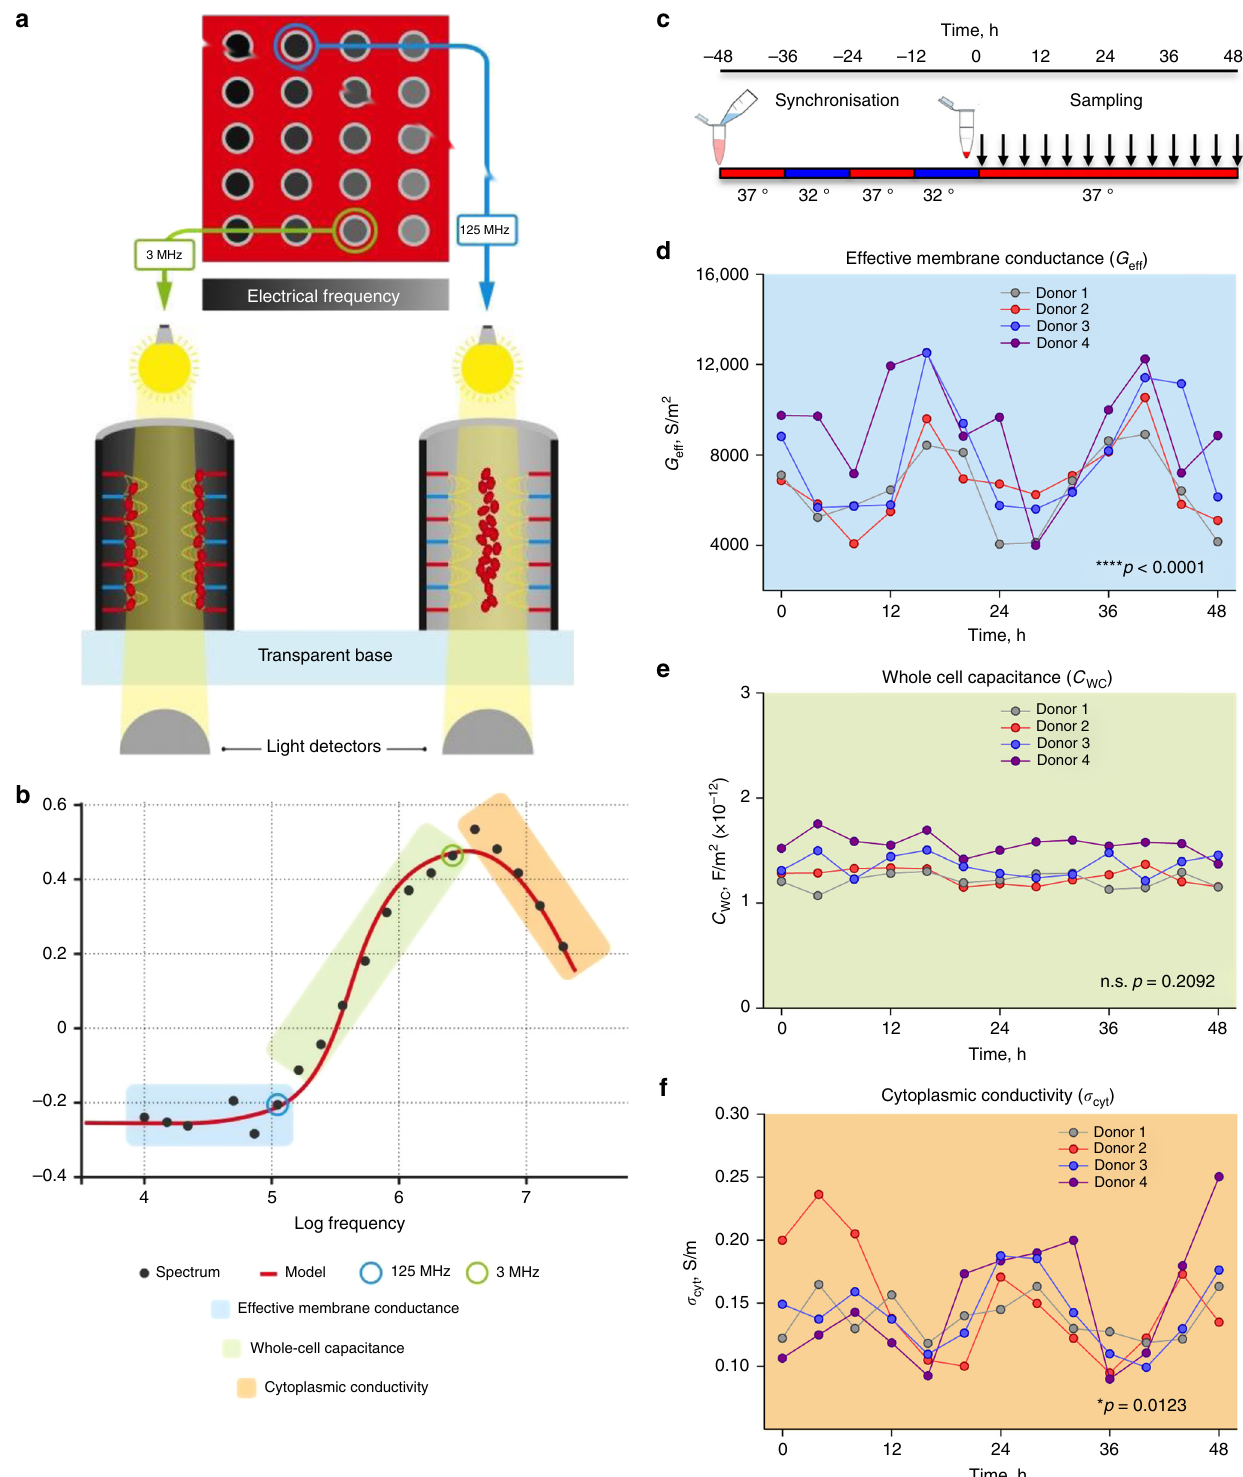
Fig. 1 Circadian rhythms in human RBC electrophysiology are detected by dielectrophoresis. a Dielectrophoresis induces RBC movement towards the periphery (negative DEP) or centre (positive DEP) of each well as a function of applied AC frequency; this is measured by the variation in transmitted light intensity across each well. b Several electrophysiological parameters can be derived from this readout. c Human RBCs are isolated, and aliquots synchronised in parallel using 12 h:12 h 37 °C:32 °C temperature cycles over 2 days. RBCs are then maintained at constant 37 °C with a separate aliquot from each donor being analysed by DEP every 3 or 4 h over 2 days. d Effective membrane conductance (G eff ) exhibits signi fi cant variation, p < 0.0001 for time effect by two-way ANOVA ( n = 4, df = 12, F = 6.4). e Whole-cell capacitance ( C WC ) shows no signi fi cant variation over time, p = 0.2092 for time effect by two-way ANOVA ( n = 4, df = 12, F = 1.4). f Cytoplasmic conductivity ( σ cyt ) also showed signi fi cant variation, p = 0.0123 for time effect by two- way ANOVA ( n = 4, df = 12, F =